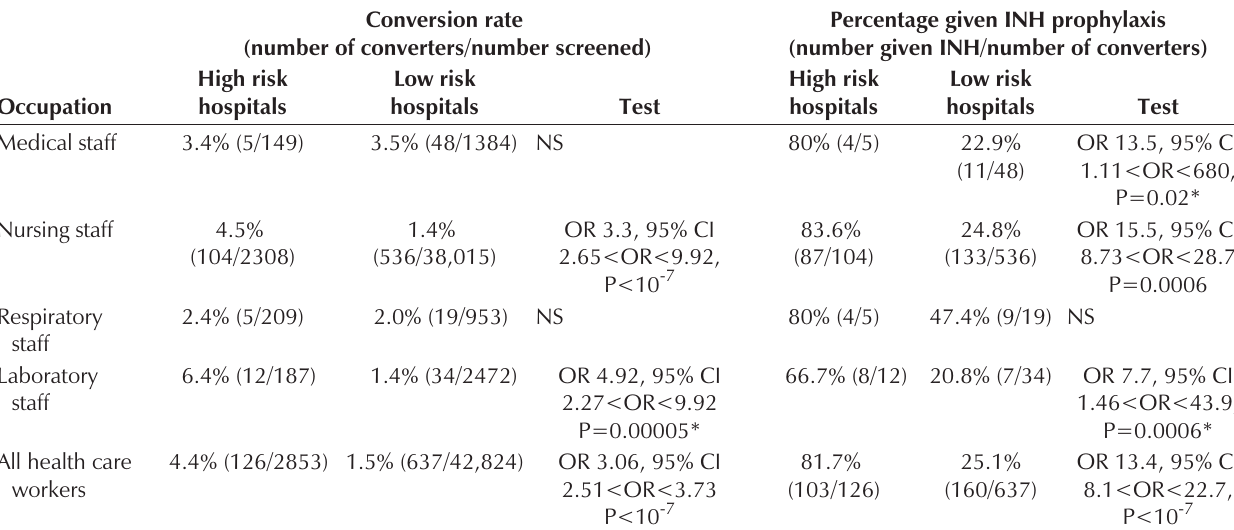
Results of tuberculosis screening programs in high and low risk hospitals Conversion